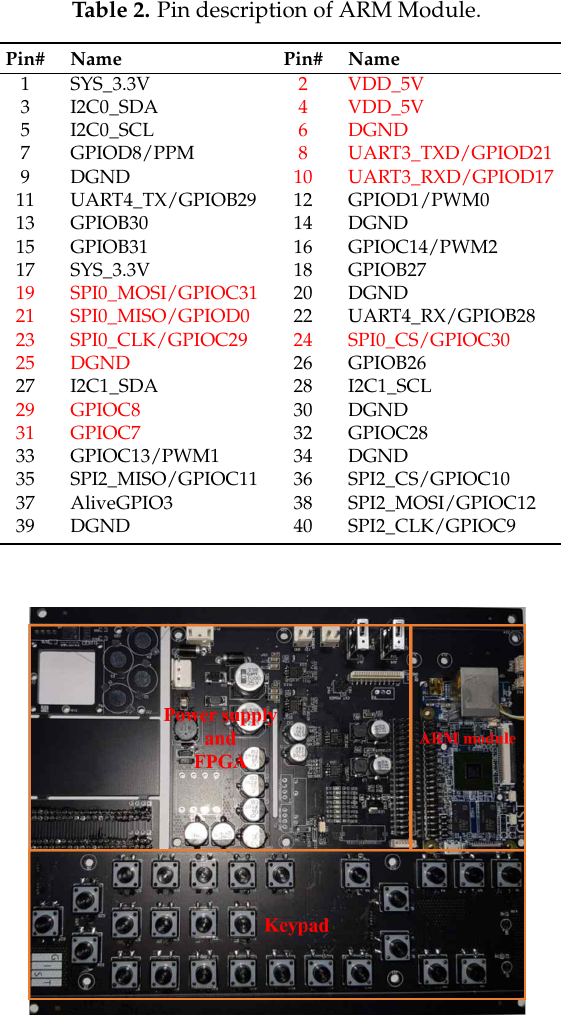
Figure 3. The printed circuit board of the motherboard used in